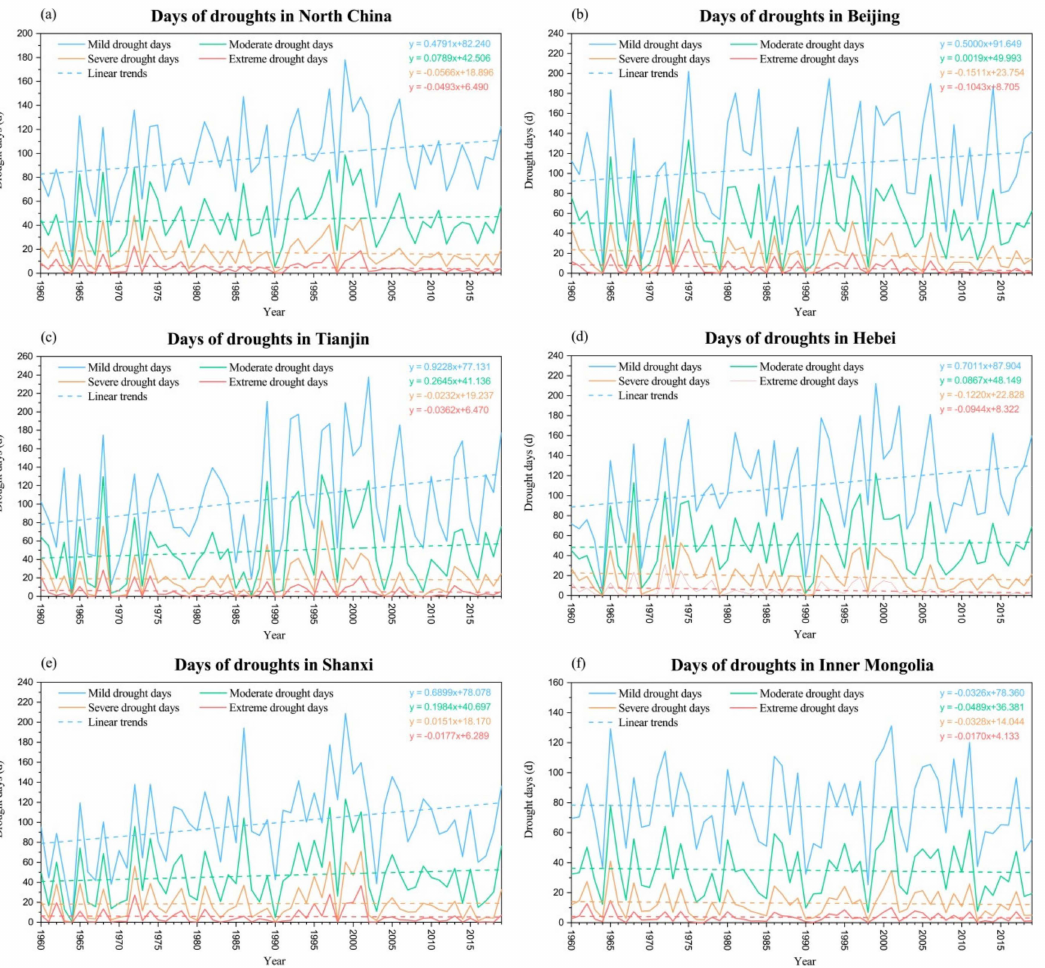
Figure 6. Interannual variation and linear trend from mild drought to extreme drought in North China ( a ), Beijing ( b ), Tianjin ( c ), Hebei ( d ), Shanxi ( e ) and Inner Mongolia ( f ) from 1960 to